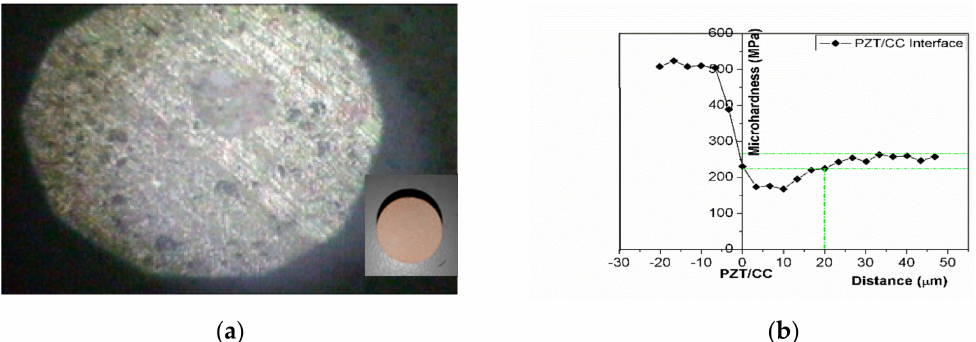
Figure 5. ( a ) An optical microscope image of the surface-polished PZTCC composite ( × 400) and (the insert bottom-right picture of the PZTCC composite at macro-scale); ( b ) Micro-hardness distributions at the PZT/CC interface.